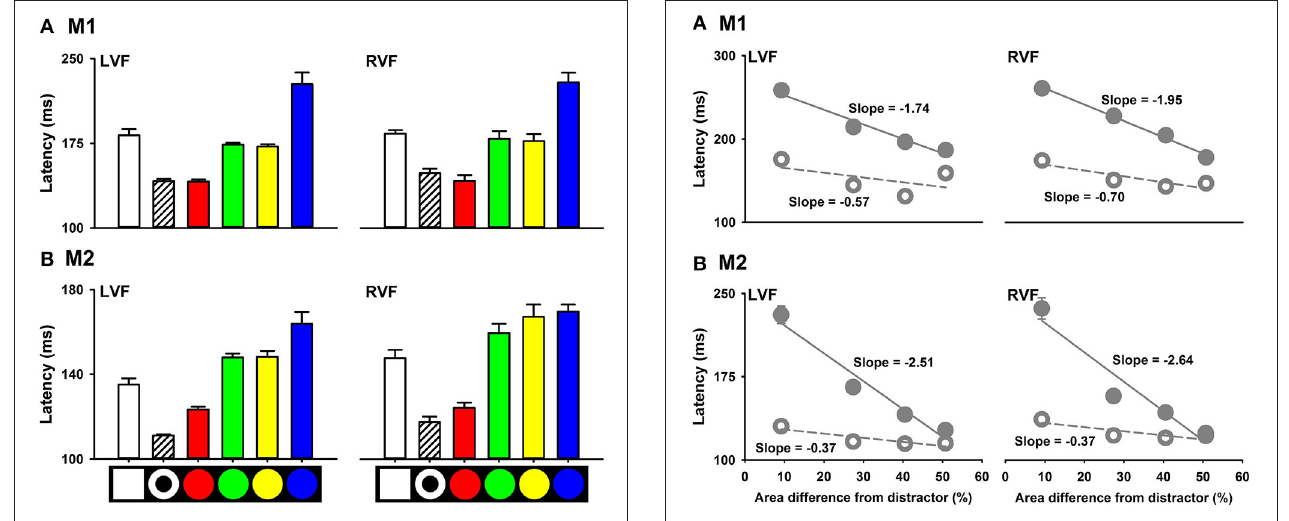
it is important to rule out luminance as a confounding